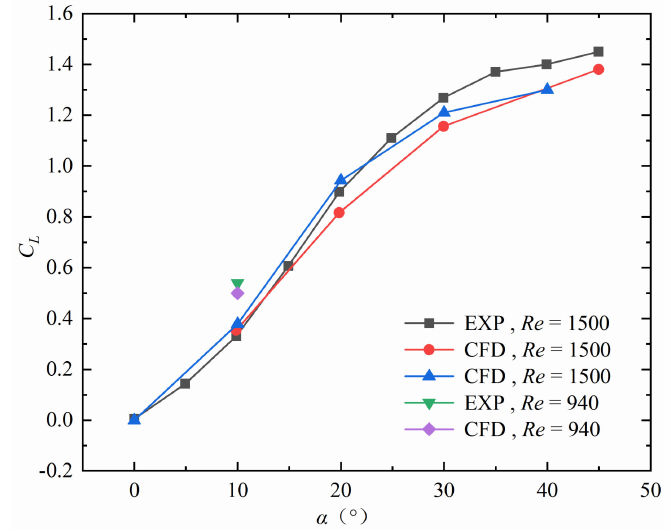
Figure 6. Comparison of the lift coefficient variation for the wings with AOA at Re of 940 and 1500